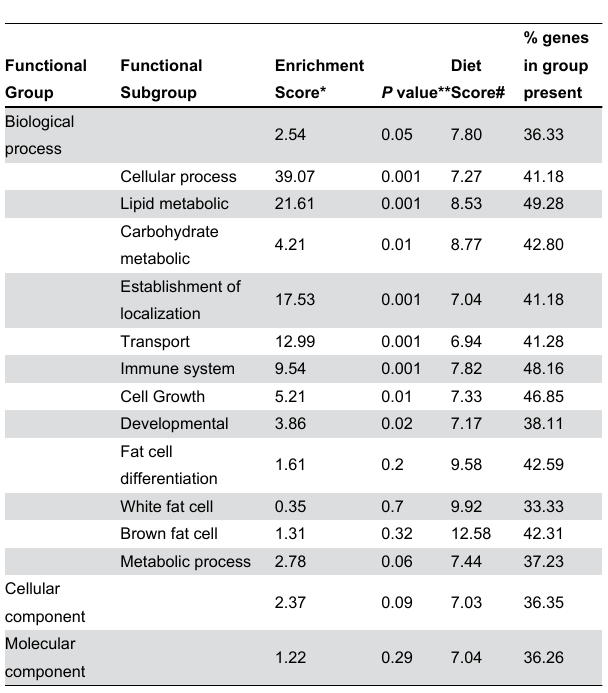
Table 3. Epididymal adipocyte genes most highly up- and down-regulated by a high fat diet at 6 months of